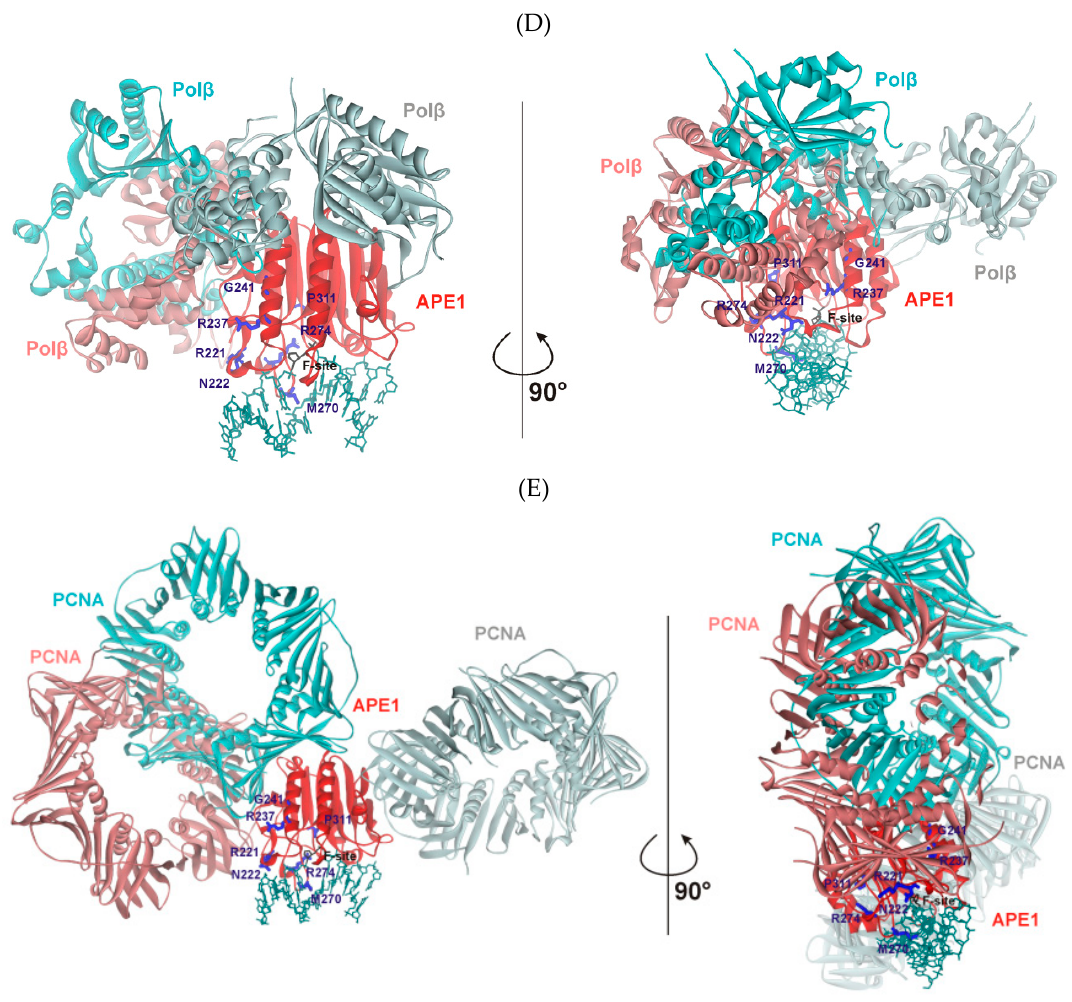
Figure 4. Protein–protein docked models of APE1 complexes with BER enzymes: OGG1 ( A ), AAG ( B ), UNG2 ( C ), Pol β ( D ), or PCNA ( E ). The PDB structures employed for the docking are 1DE8 for APE1, 1EBM for OGG1, 1F4R for AAG, 1EMH for UNG2, 4PHD for Pol β , and 6FCM for PCNA. Int. J. Mol. Sci. 2020 , 21 , x FOR PEER REVIEW